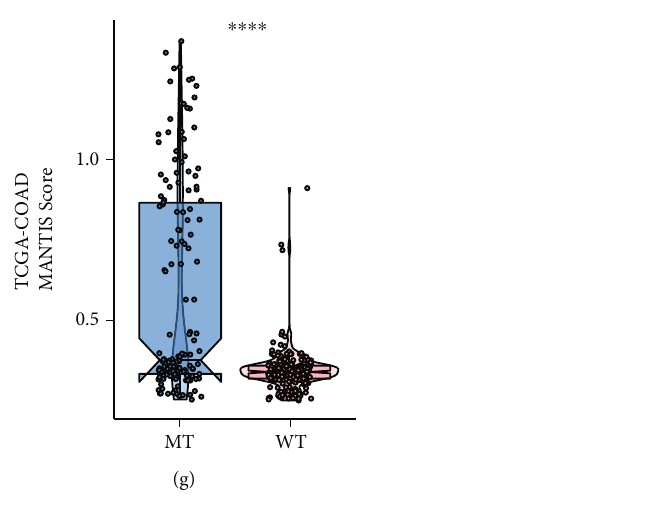
Figure 3: The relationship between PI3K/Akt pathway mutations and enhanced immunogenicity. (a) Comparison of DDR mutations in the PI3K/Akt-MT and PI3K/Akt-WT groups in the immunotherapy cohort. (b) Comparison of TMB in the PI3K/Akt-MT and PI3K/Akt-WT groups in the immunotherapy cohort. (c) Comparison of DDR mutations in the PI3K/Akt-MT and PI3K/Akt-WT groups in the TCGA cohort. (d) Comparison of TMB in the PI3K/Akt-MT and PI3K/Akt-WT groups in the Local-COAD cohort. (e) Comparison of TMB between PI3K/Akt-MT and PI3K/Akt-WT groups in the TCGA cohort. (f) Comparison of NAL between PI3K/Akt-MT and PI3K/Akt- WT groups in the TCGA cohort. (g) Comparison of MANTIS scores of the PI3K/Akt-MT and PI3K/Akt-WT groups in the TCGA cohort ( ∗ P < 0 : 05 ; ∗∗ P < 0 : 01 ; ∗∗∗ P < 0 : 001 ; ∗∗∗∗ P < 0 : 0001 ; Mann – Whitney U